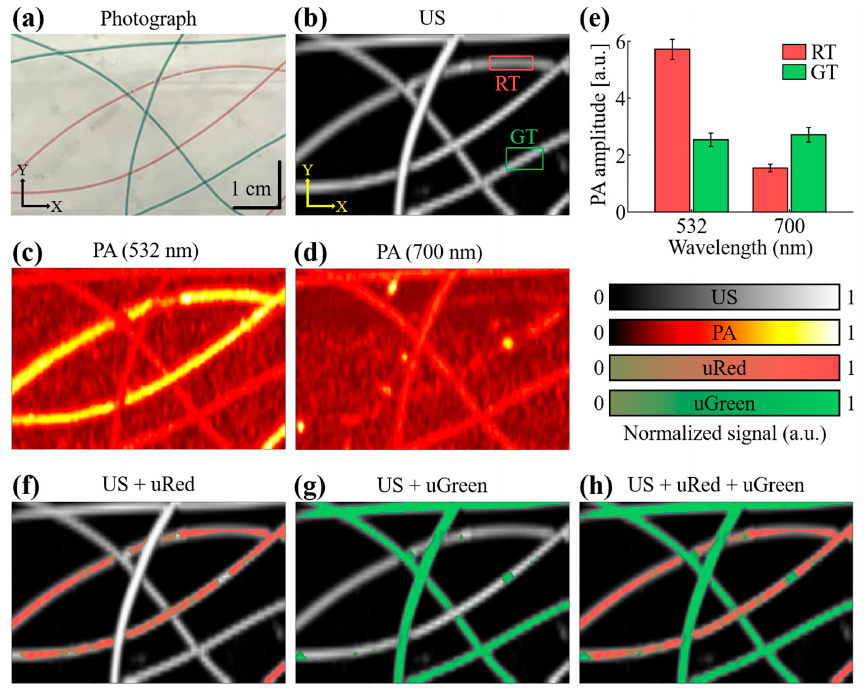
Figure 3. In vitro imaging of the blood vessel mimicking phantom. ( a ) Photograph of the phantom. ( b ) US MAP image of the phantom. Red and green rectangular indicate the ROI of the RT and GT for quantification. ( c , d ) Normalized PA MAP images of the phantom with the excitation wavelength of 532 and 700 nm. ( e ) Quantified PA amplitudes of the RT and GT. ( f – h ) Overlaid MAP images of the phantom with unmixed PA MAP images over the US MAP image. PA, photoacoustic; US, ultrasound; MAP, maximum amplitude projection; RT, red tube; GT, green tube; uRed, unmixed red; uGreen, unmixed green.